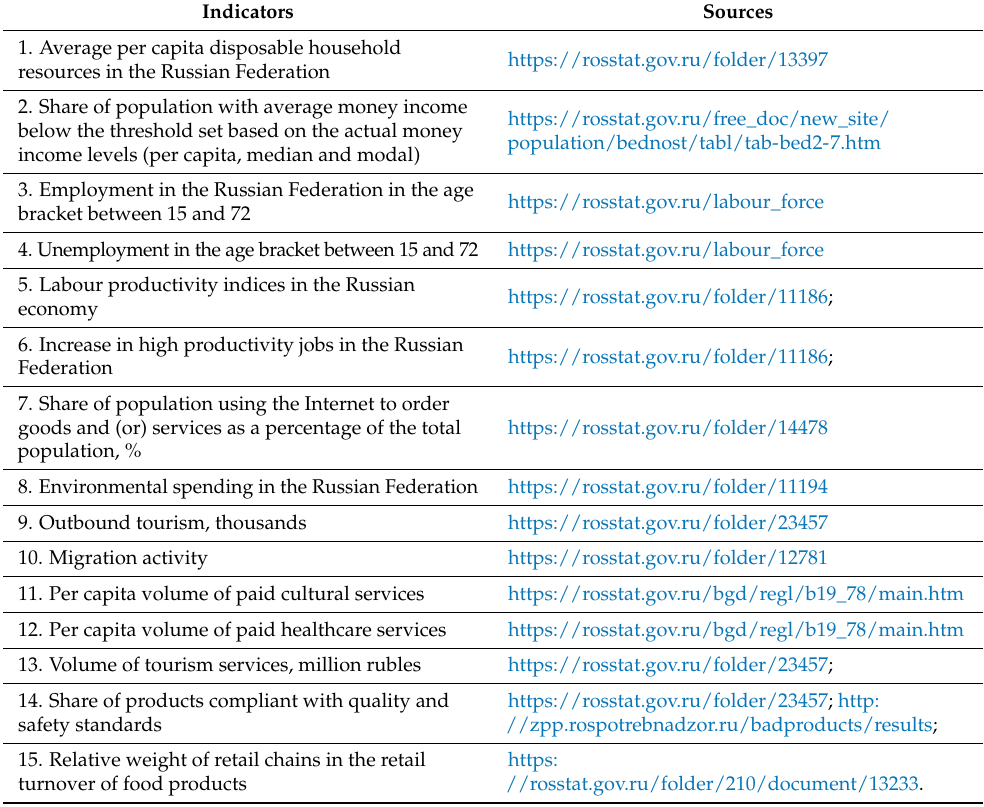
Table A1. Indicators and primary data sources on the formation of the information society and the development of socioeconomic and cultural processes and the circulation sphere in the Russian